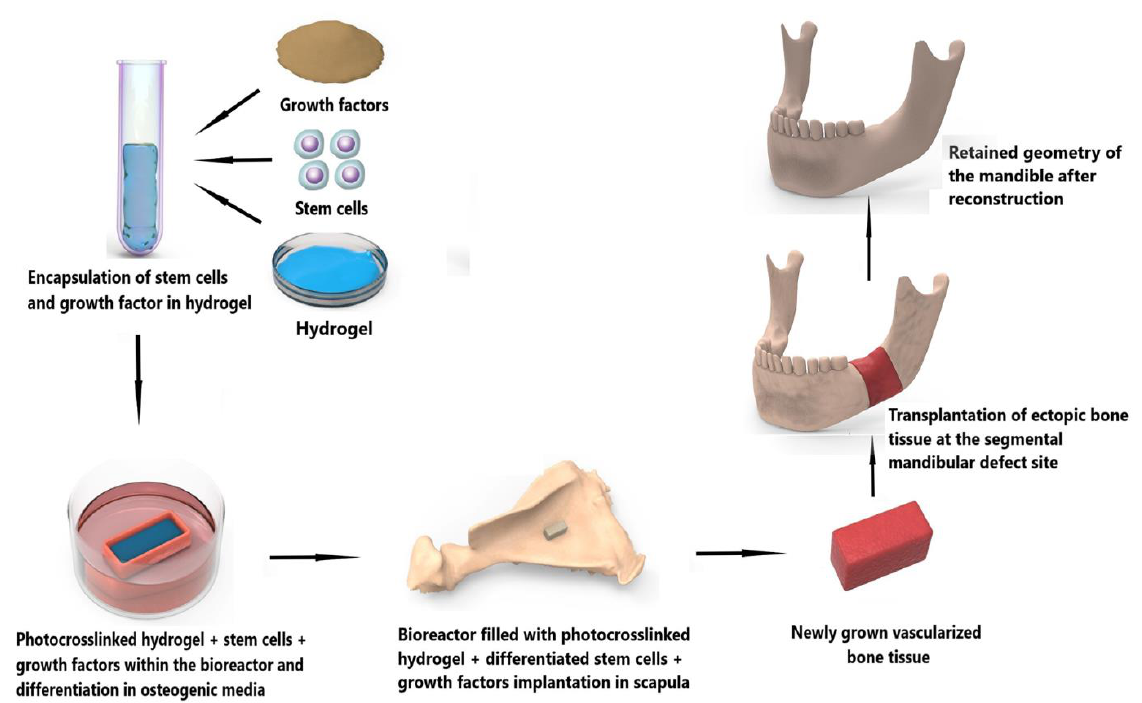
Figure 9. Application of hydrogel, stem cells, and growth factors to create customized ectopic bone with a goal to repair a segmental mandibular defect.